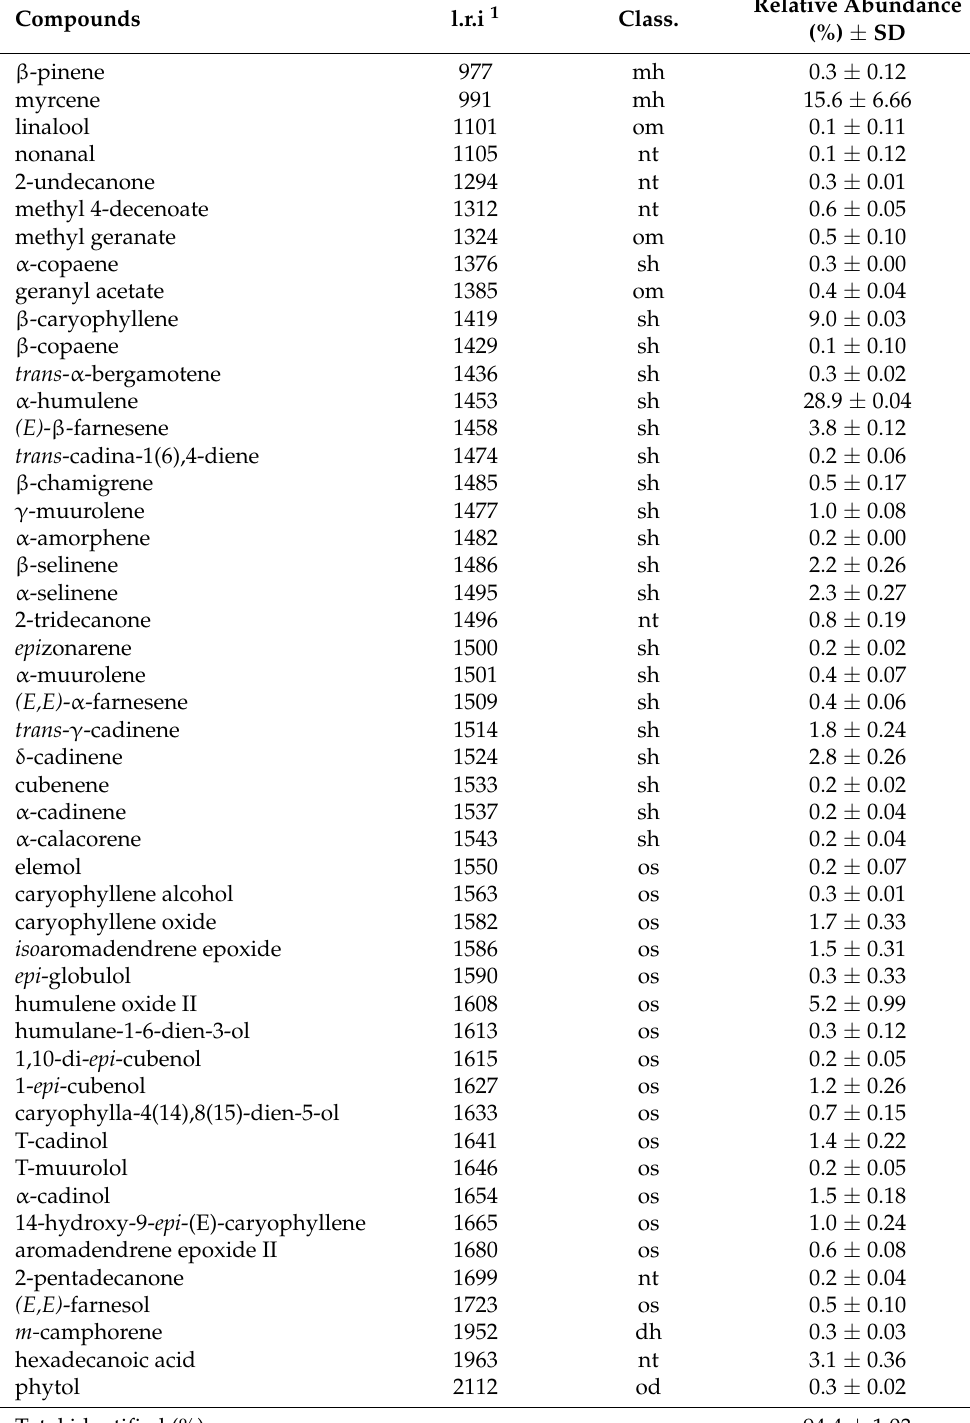
Table 2. Chemical composition and extraction yield of the essential oil from the cones of Humulus lupulus L.